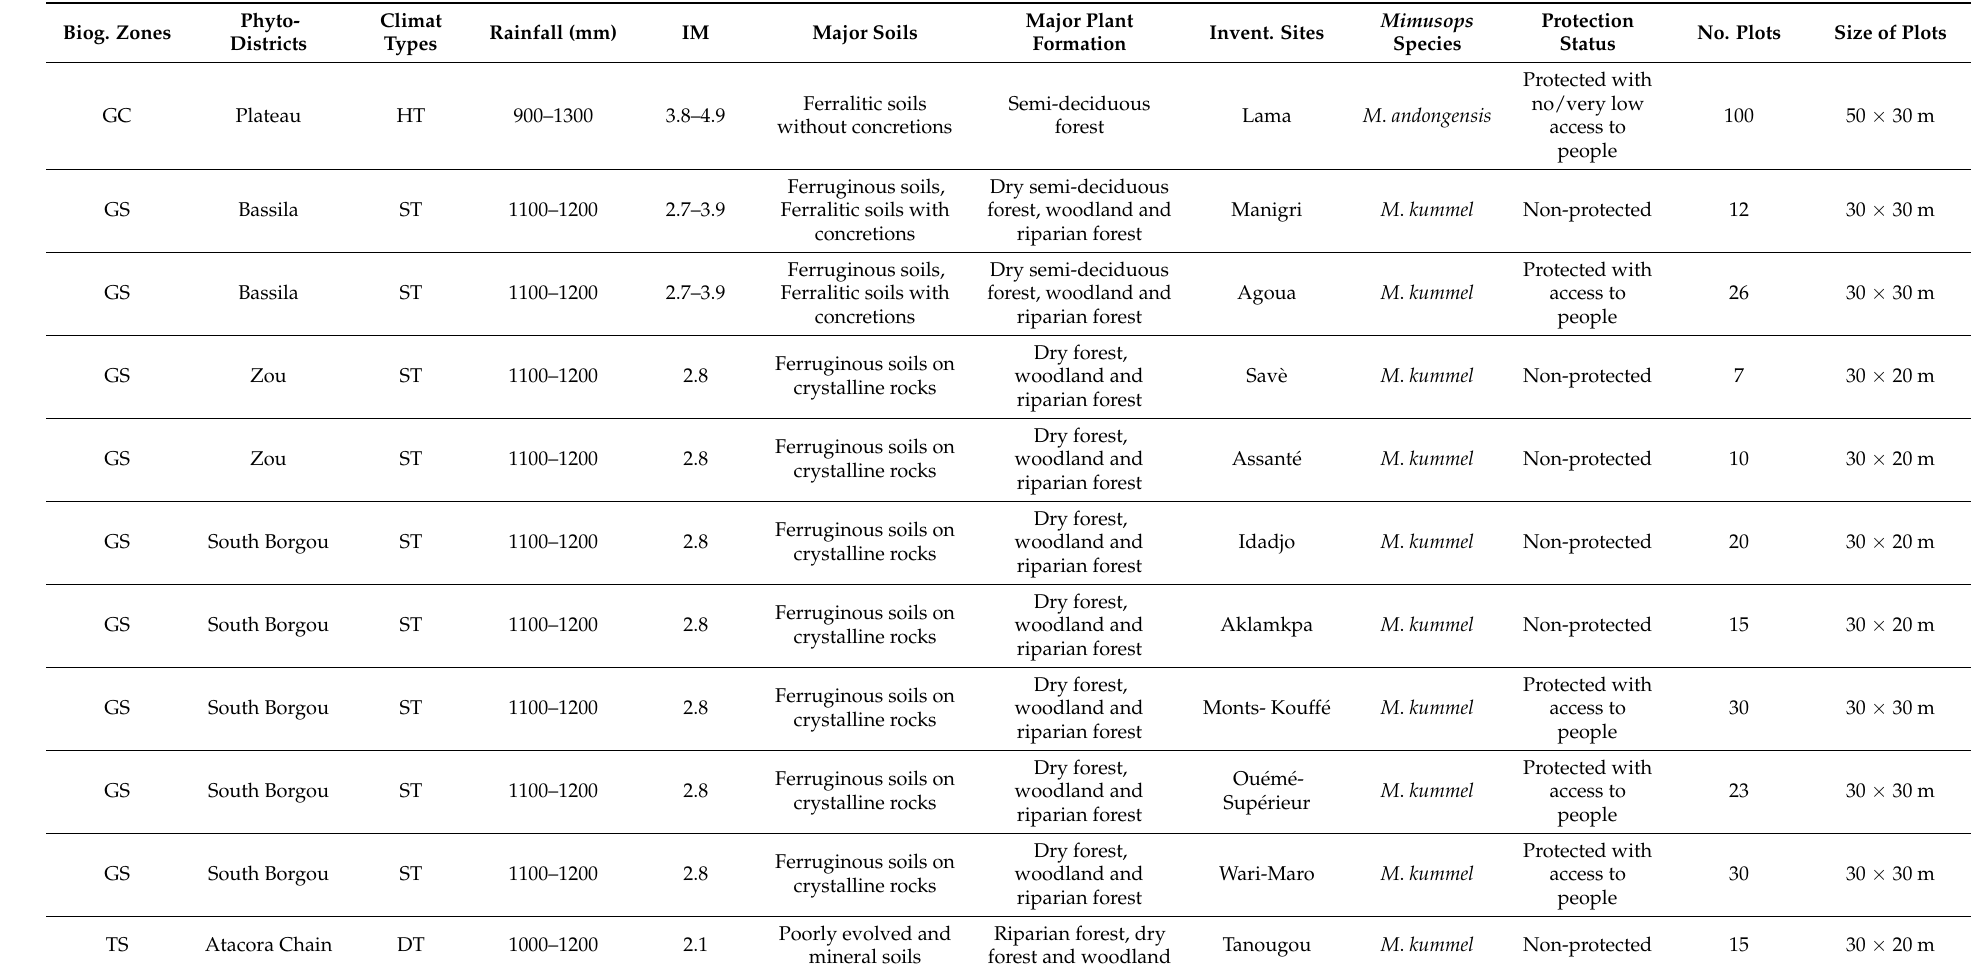
Table 1. Ecological characteristics in the different biogeographical zones and the investigated forests (Adapted from [22]). Biog.